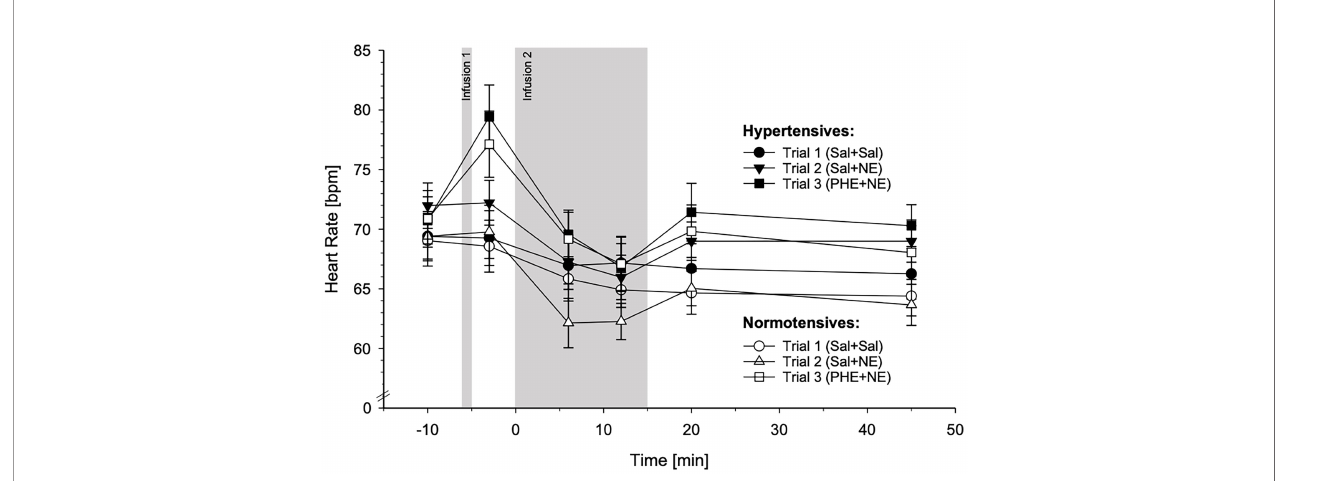
FIGURE 5 | Heart rate (HR) reactivity to the three different substance infusion-trials (trial 1: Sal+Sal, circles; trial 2: Sal+NE, triangles; trial 3: PHE+NE, rectangles) in hypertensive participants (HT; black symbols; n = 23) and normotensive controls (NT; white symbols; n = 23) ( mean ± SEM ). HR reactivity across the three trials did not differ between HT and NT as revealed by the calculated general linear model (interaction trials-by-group-by-time: p =